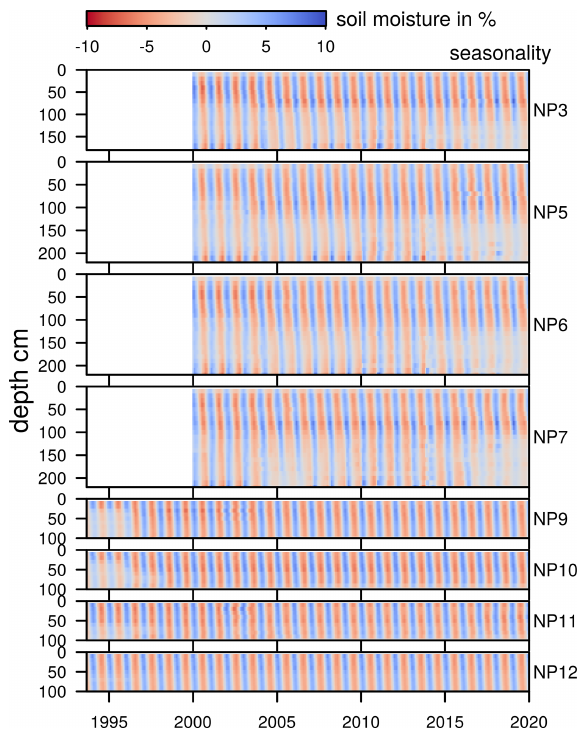
Figure A6. Seasonal component of the soil moisture time